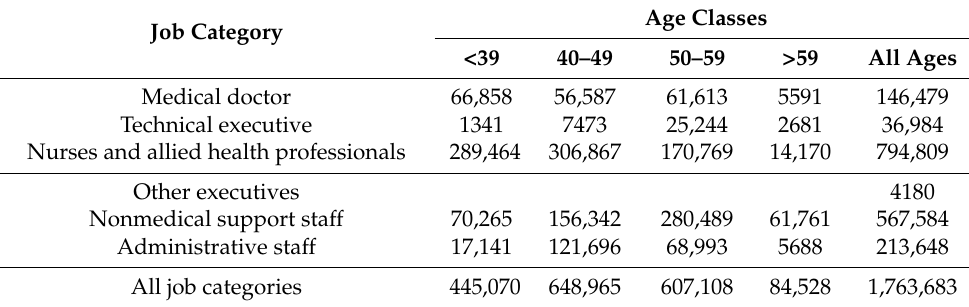
Table 4. Costs for days lost/year in epidemic periods